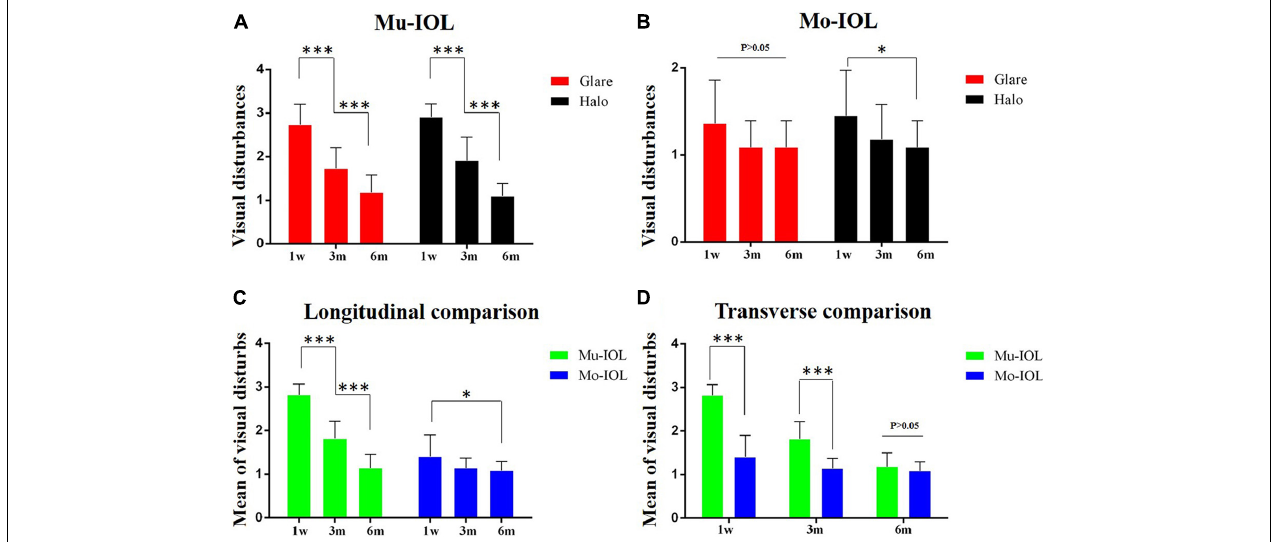
FIGURE 2 | Comparison of visual disturbances between two groups. (A) Visual disturbances ratio for glare and halos faded away gradually during the follow-up in the Mu-IOL group; (B) Visual disturbances ratio for halos reduced stepwise during the follow-up in the Mo-IOL group; (C) The mean of visual disturbances diminished gradually in both Mu-IOL and Mo-IOL groups; (D) The mean value in the Mu-IOL group was more severe than in the Mo-IOL group at 1 week or 3 months postoperation. BA, Brodmann area; Mo-IOL, monofocal intraocular lens; Mu-IOL, multifocal intraocular lens; 1 w, 1 week postoperatively; 3 m, 3 months postoperatively; 6 m, 6 months postoperatively; pre, preoperatively ( ∗ < 0.05; ∗∗∗ < 0.001).